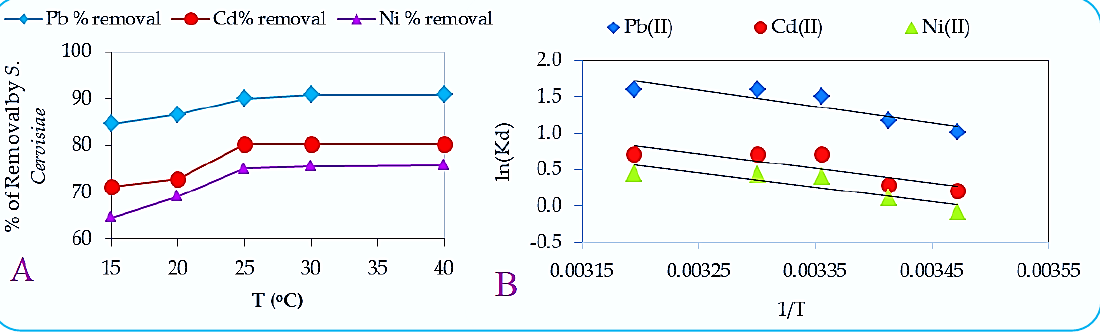
Figure 5. ( A ) Removal efficiency versus temperature, and ( B ) ln(K d ) versus 1/T of Cd(II), Pb(II), and Ni(II) ions’ adsorption by S. cerevisiae biomass. Table 5. Values estimated from the thermodynamic analysis.